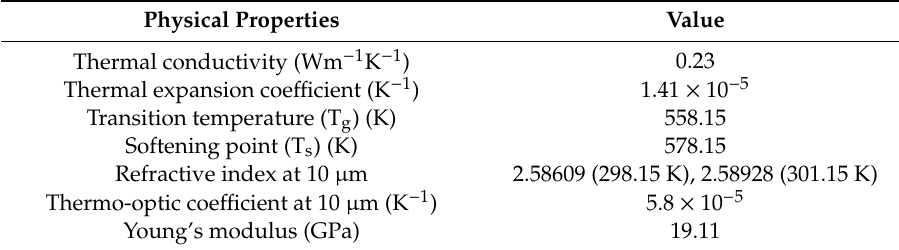
Table 1. Thermal and mechanical properties of chalcogenide glass (NBU-IR1).